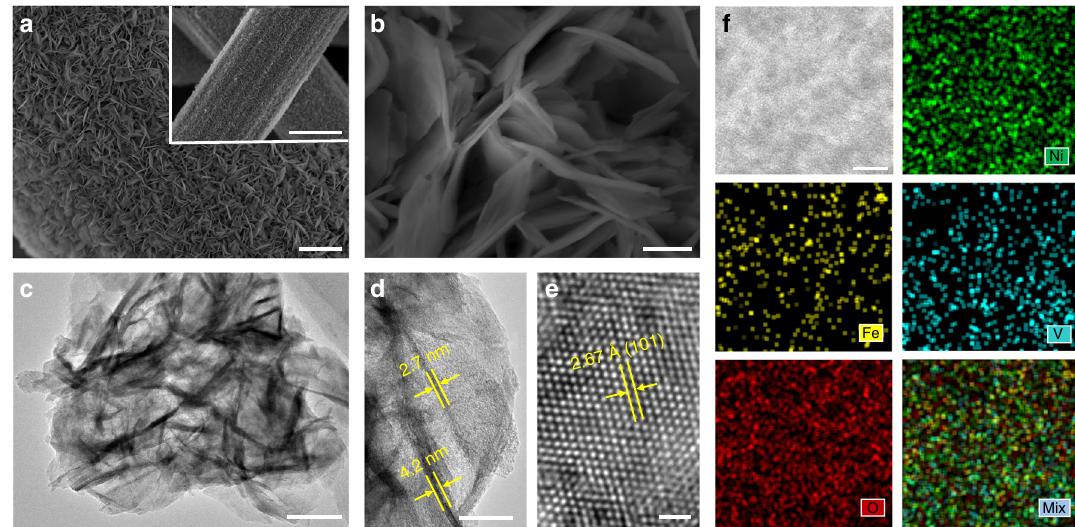
Fig. 2 Microscopy measurements of Ni 3 Fe 0.5 V 0.5 NSs. a , b Top-view SEM images of the carbon fi ber coated with Ni 3 Fe 0.5 V 0.5 NSs with low ( a ) and high ( b ) magni fi cation. Scale bars, 1 μ m in a and 100 nm in b . The inset in a shows the hierarchically structured 3D integrated electrode. Scale bar in the inset in a , 5 μ m. c , d TEM images of Ni 3 Fe 0.5 V 0.5 NSs scratched off from the as-prepared CFP electrode. Scale bars, 100 nm in c and 40 nm in d . e Atomic-resolution BF- TEM image of Ni 3 Fe 0.5 V 0.5 NSs. Scale bar, 1 nm. f Aberration-corrected HAADF-STEM image of Ni 3 Fe 0.5 V 0.5 NSs, the corresponding EDX elemental